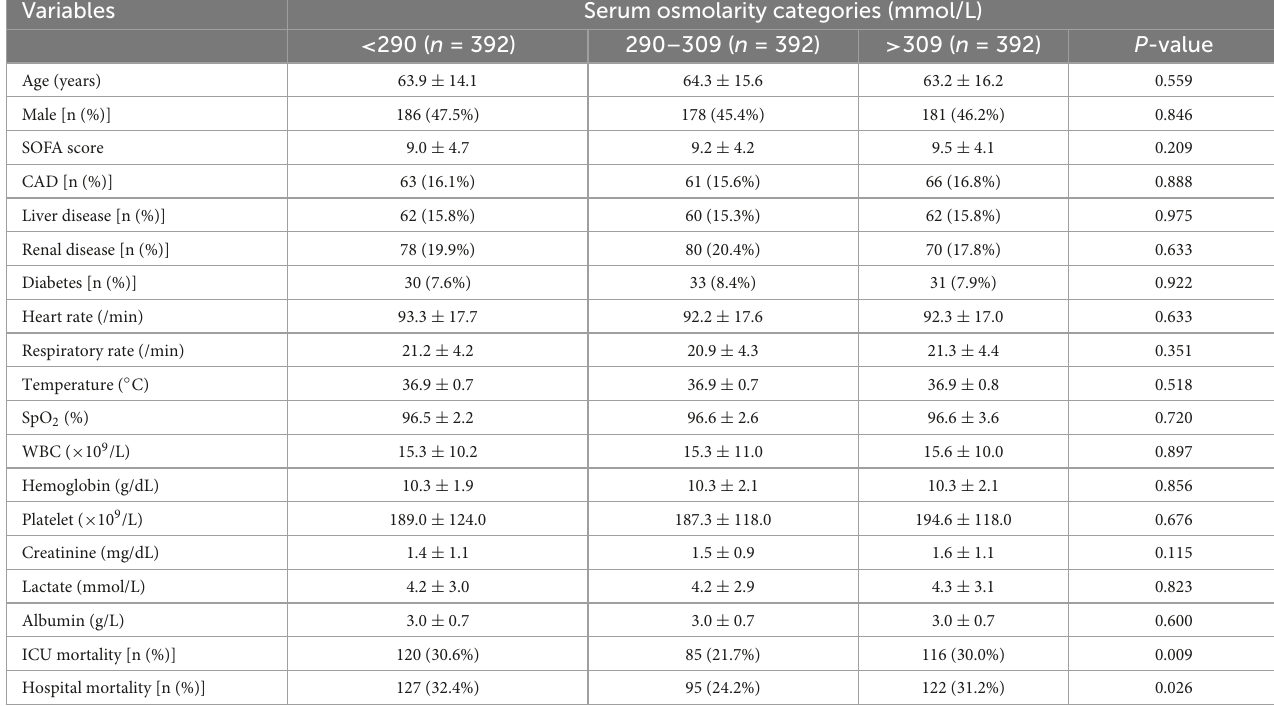
TABLE 3 Comparison of clinical characteristics between different serum osmolarity groups after PSM.